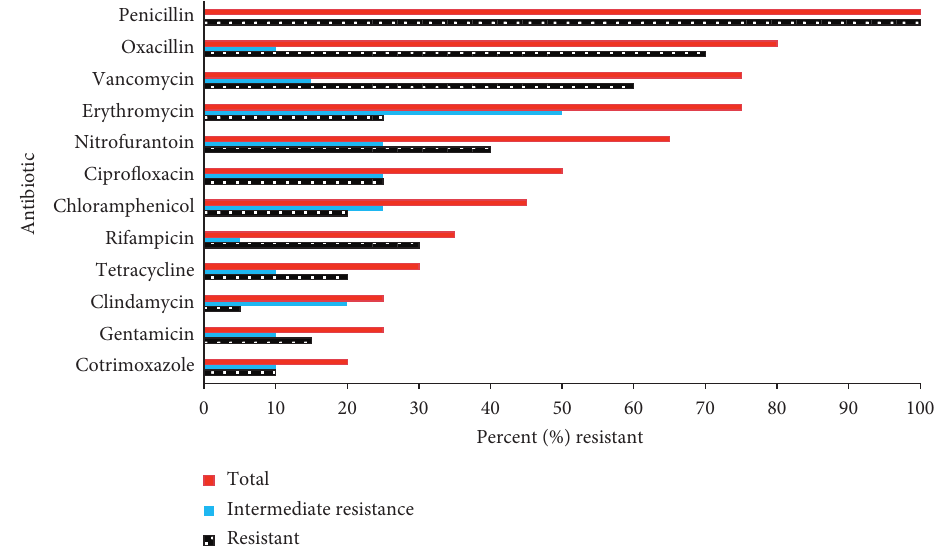
Figure 1: Disk diffusion test for Gram-positive isolates on 12 antibiotics, on Mueller–Hinton agar with 4% NaCl, as recommended in the Clinical and Laboratory Standards Institute guidelines. Table 3: Disk diffusion test for Gram-negative isolates on 11 antibiotics, on Mueller–Hinton agar with 4% NaCl, as recommended in the Clinical and Laboratory Standards Institute guidelines.